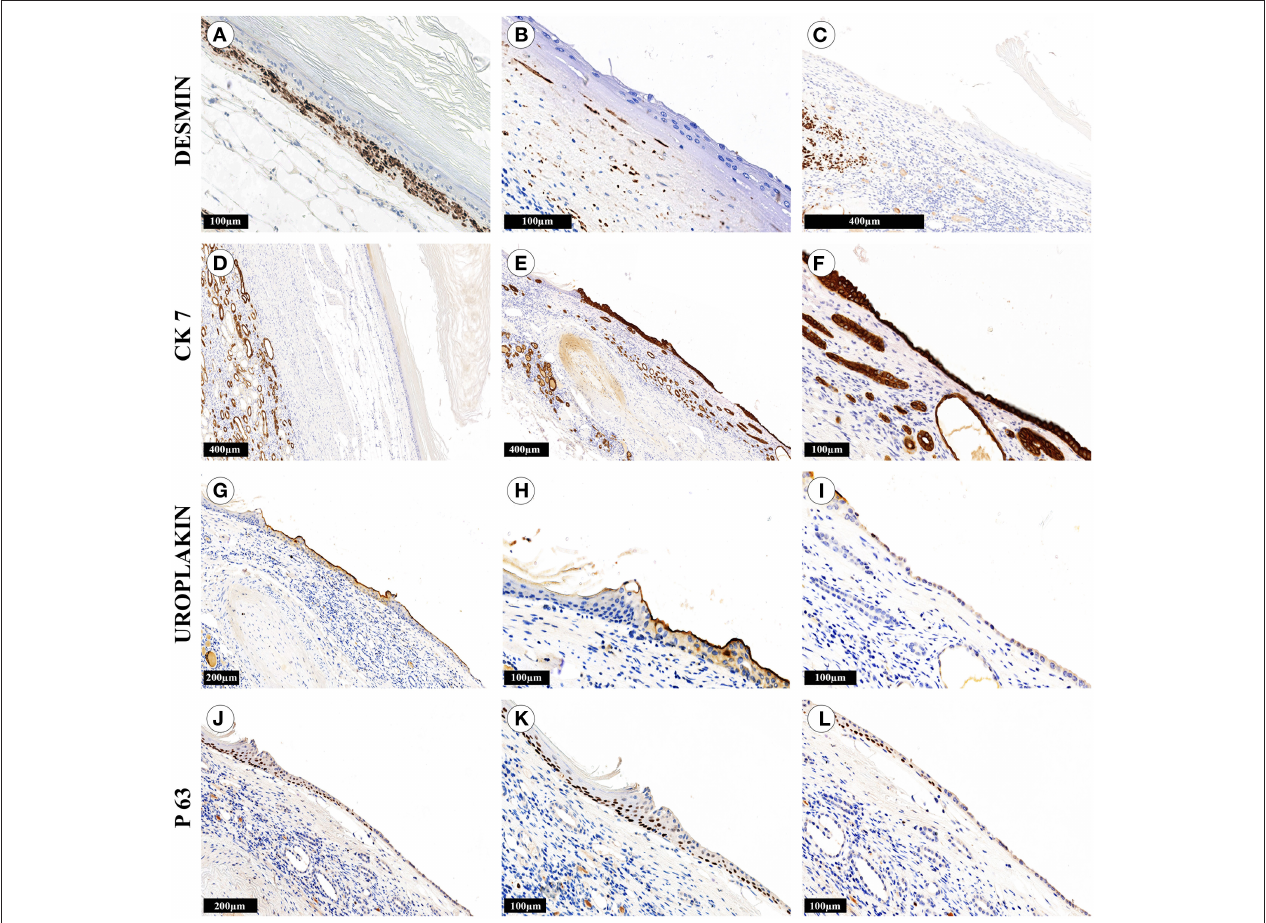
FIGURE 3 | Immunohistochemical study of kidney cystic lesion. The cyst wall areas contained numerous smooth muscle cells (A) , singular cells (B) or completely lacked the cells (C) . (D–F) The cuboidal epithelium, urothelium and epithelium of the kidney tubules were strongly positive for CK7, while the stratified squamous epithelium did not express the marker. (G–I) The urothelium was positive for uroplakin III, while the cuboidal epithelium expressed this marker weakly and irregularly. (J–L) The multilayer squamous epithelium and tubule epithelium were not stained with antibodies against uroplakin III, but expressed p63. The cuboidal cyst epithelium had weak and focal positive expression of p63, the epithelium of the tubules was not